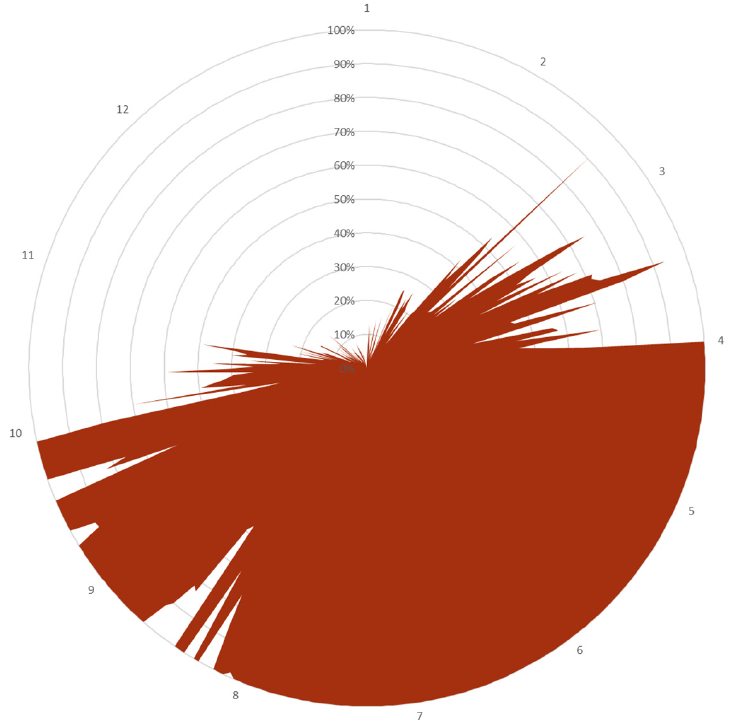
Figure 8. Providing electricity throughout the year for the needs of WDS.